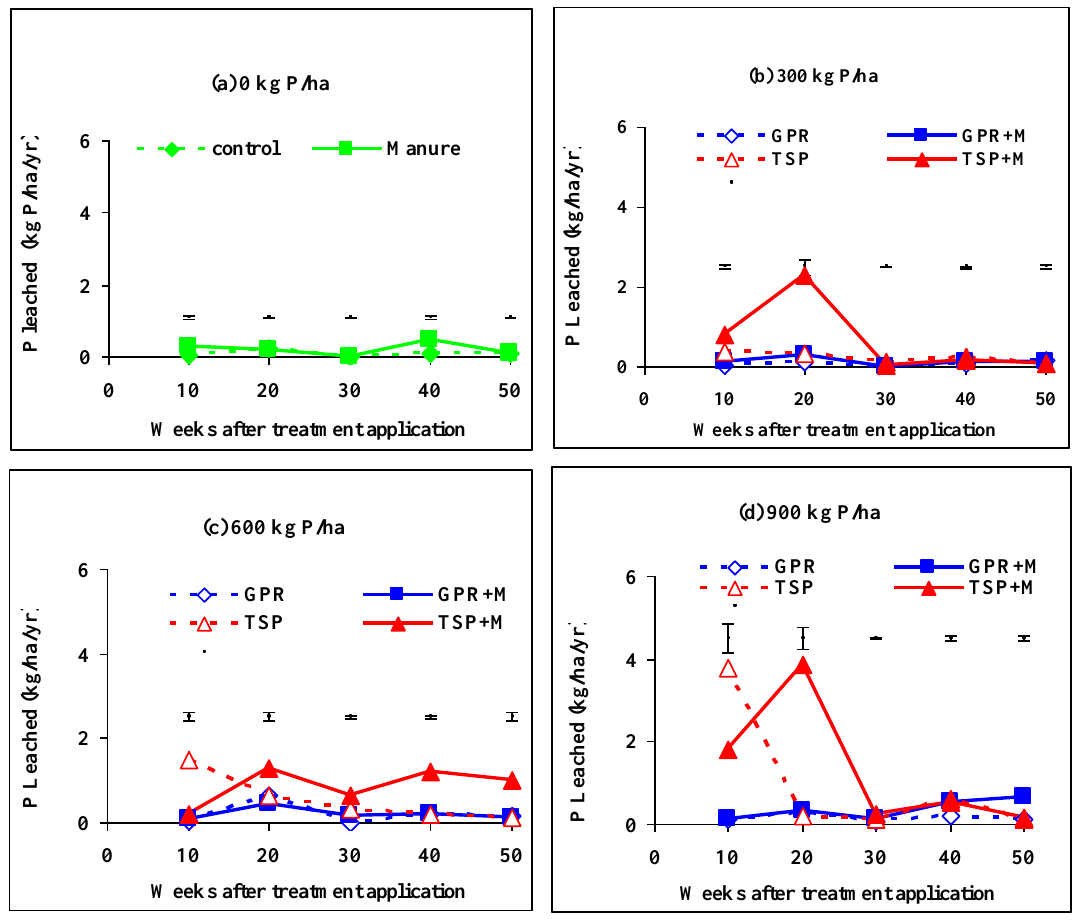
FIGURE 4. Effect of P source, plus/minus manure at different P rates on P leached over time. (a) At 0 kg P ha –1 (control +/– manure), (b) 300 kg P ha –1 , (c) 600 kg P ha –1 , and (d) 900 kg P ha –1 . The bars denote standard error (S.E).